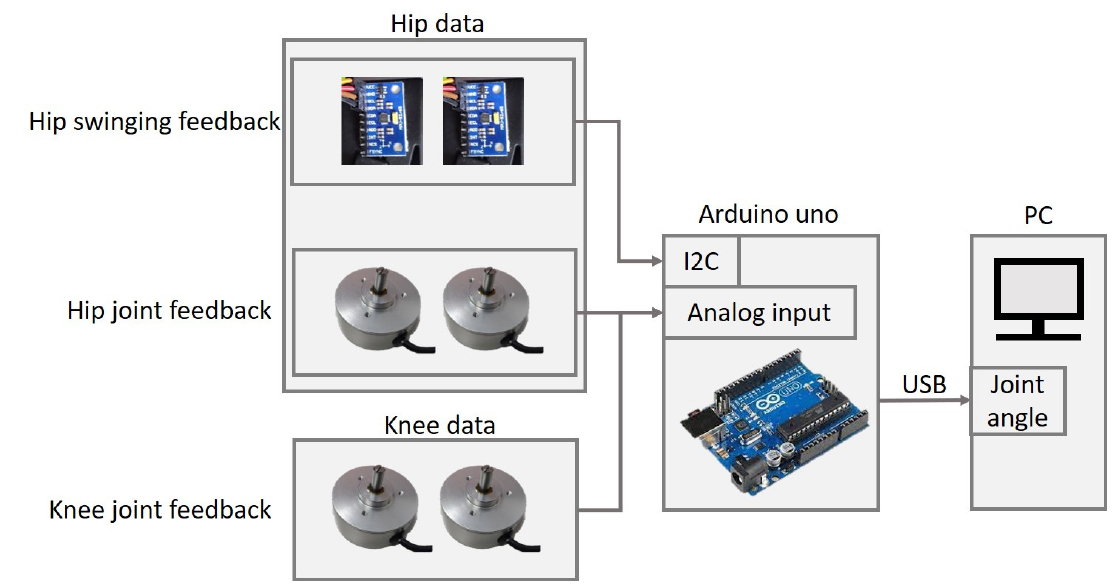
Figure 9. Unpowered exoskeleton communication architecture.